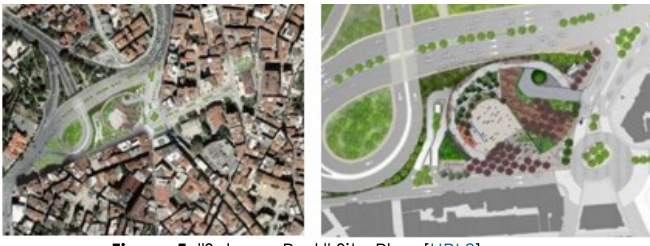
Figure 5: "Şışhane Park" Site Plan [